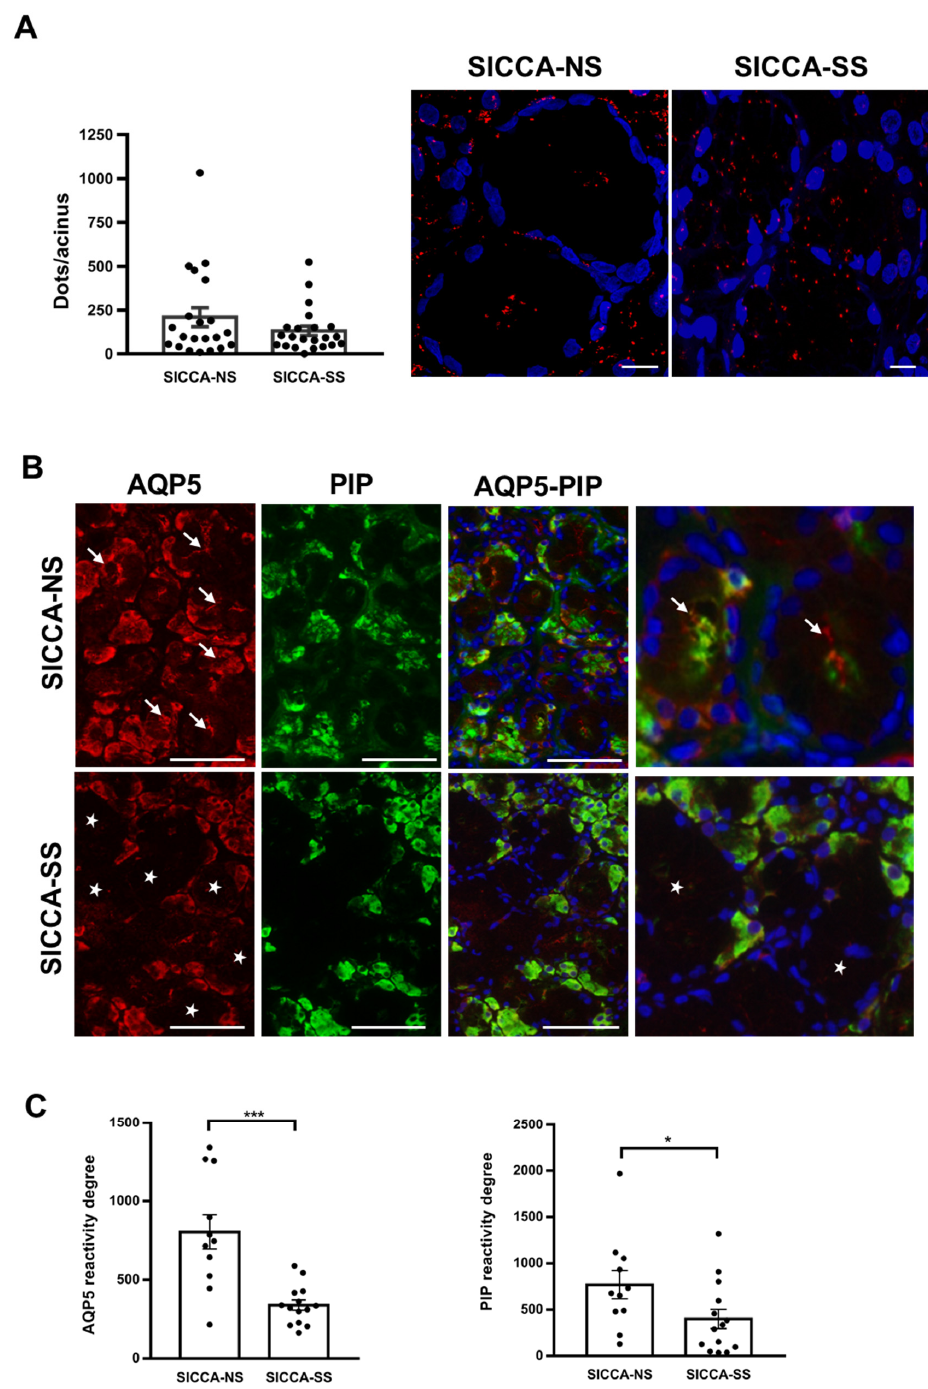
Figure 6. Sjögren’s syndrome alters the expression of AQP5-PIP complexes, and AQP5 and PIP in hMSG. (( A ) Left ), quantification of PLA red spots per acinus composed of 15 acinar cells. Results are expressed as the mean ± S.E.M cells (n = 21 SICCA-NS, 22 SICCA-SS). Statistical analysis was performed using Mann Whitney u test; p > 0.05. (( A ) Right ), PLA on hMSG biopsy from SICCA-NS and SICCA-SS. Nuclei were labeled with DAPI (blue) and interactions are represented by red spots. Scale bar, 10 µ m. ( B ) Immunofluorescence of AQP5 (red) and PIP (green) in SICCA-NS and SICCA-SS hMSG. Scale bar; 75 µ m. Negative controls are shown in Appendix A Figure A1, right. ( C ) Semi-quantitative evaluation of AQP5 and PIP expression. Results are expressed as the mean ± S.E.M. (n = 11 SICCA-NS, n = 14 SICCA-SS). Statistical analysis was performed using Mann Whitney u test, * p < 0.05; *** p <